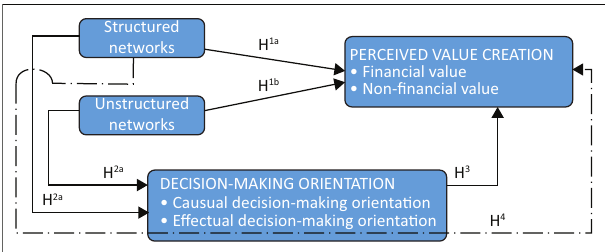
FIGURE 1: Proposed hypothesised model.